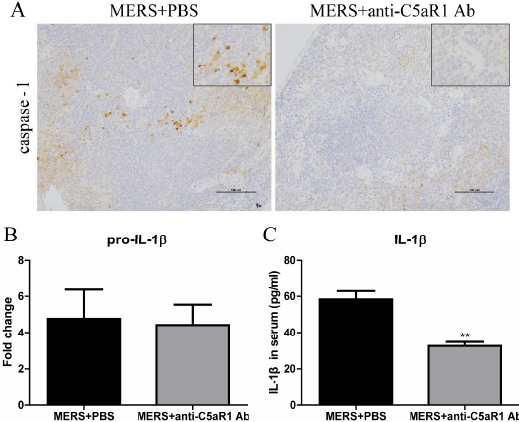
Figure 5. Blocking the C5a-C5aR1 axis reduces pyroptosis in hDPP4-transgenic mice. ( A ) anti-C5aR1 Ab-treated groups on Day 7 post-challenge (scale bars = 100 μm). ( B ) Transcription of pro-